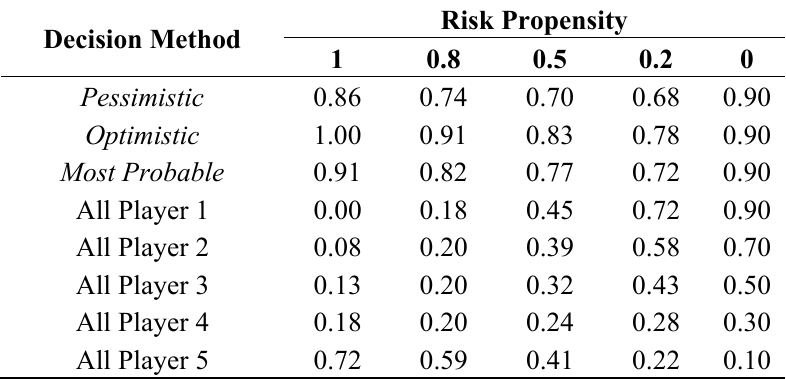
Table 3. Utility function values for different risk propensity